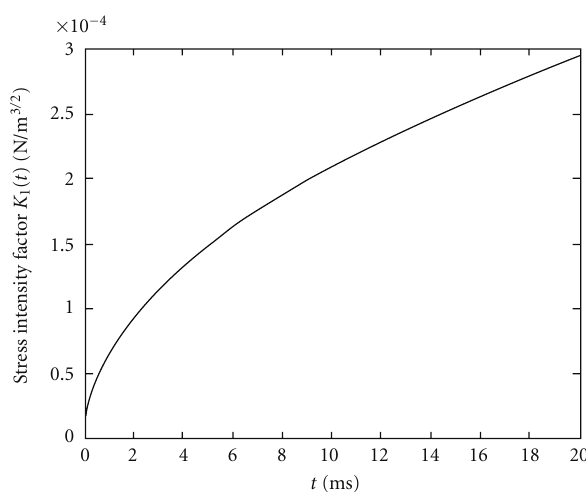
Figure 5: Dynamic stress intensity factors versus